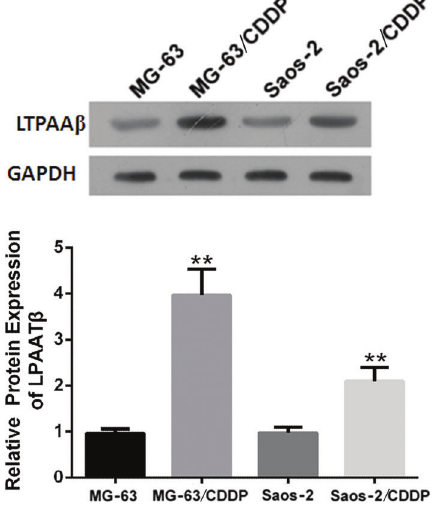
Figure 4. LPAAT b was up-regulated in cisplatin (CDDP)-resistant osteosarcoma cells. The expression of LPAAT b was examined in MG-63, Saos-2, MG-63/CDDP, and Saos-2/CDDP cells using western blot analysis. GAPDH served as loading control. Upper: representative image of western blot analysis. Lower: histogram represents the densitometry data for at least 3 independent experiments. Data are reported as means ± SD. **P o 0.01, compared to its respective control (Student ’ s t